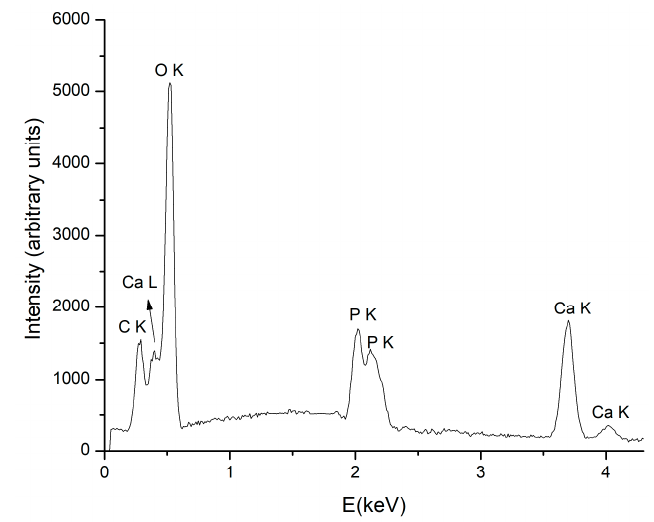
Figure 9. EDS spectrum of calcium phosphate coating obtained at 50 W and 4.6 × 10 − 3 mbarr Ar gas working pressure.